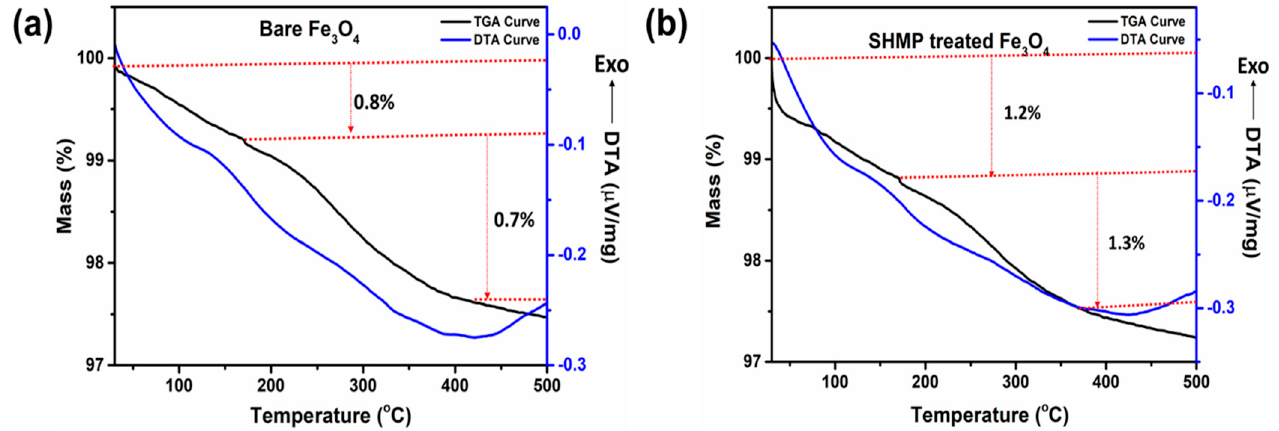
Figure 10. TG-DTA plots for ( a ) bare Fe 3 O 4 , and ( b ) SHMP-treated Fe 3 O 4 samples, respectively.